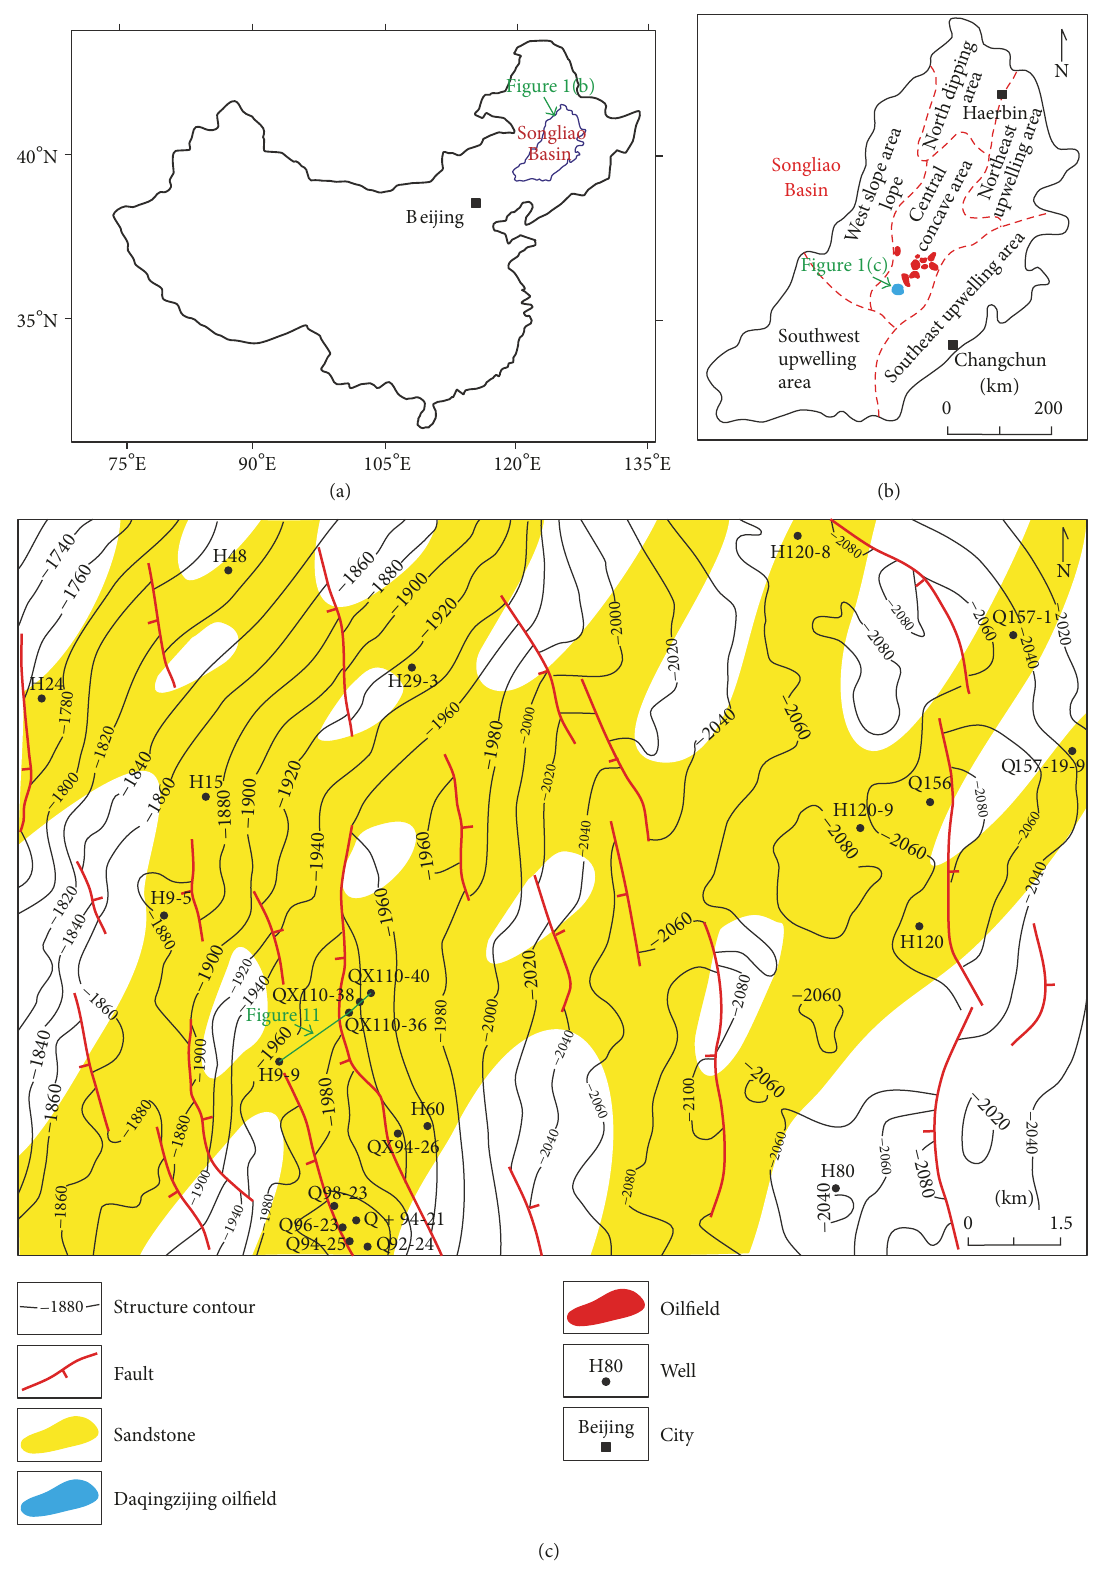
Figure1:Locationmapofthestudyarea.(a)LocationmapofSongliaoBasin.(b)SongliaoBasinstructuralzones.(c)Structuralcharacteristics and sandstone distribution map within the study